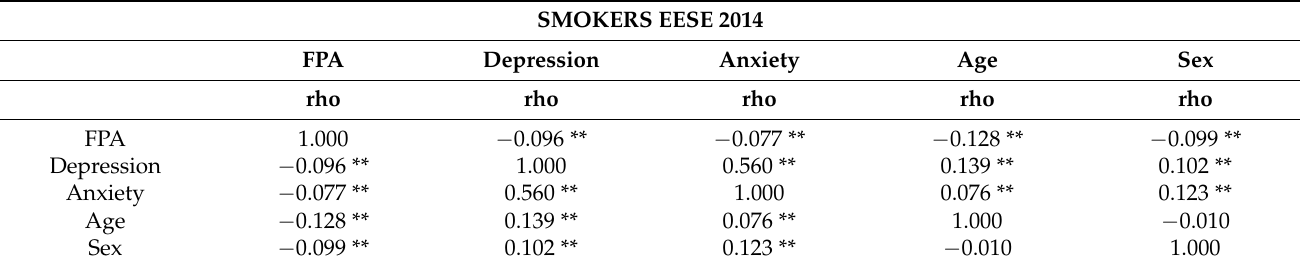
Table A4. Spearman’s bivariate correlation between frequency of physical activity, prevalence of depression and anxiety, age and sex: EESE 2014 and EESE